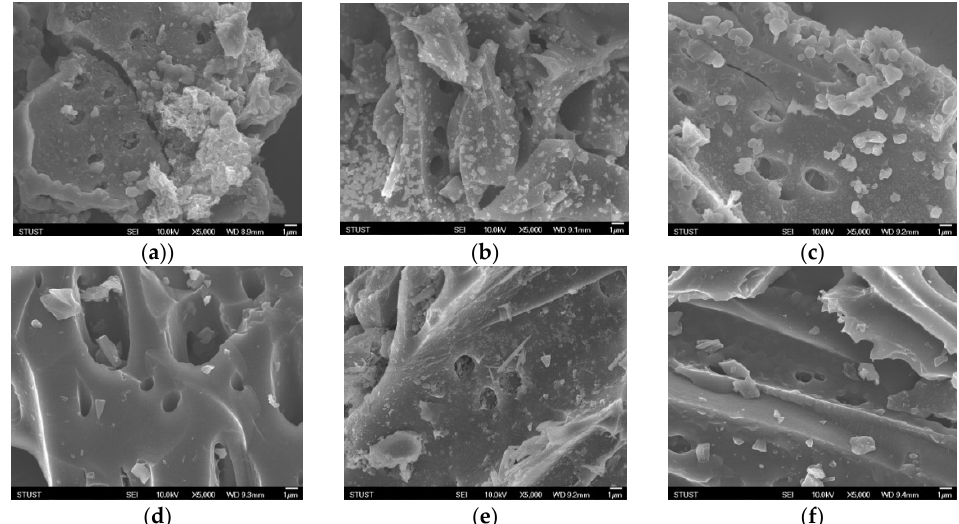
Figure 6. SEM micrographs (5000× magnification) of RFSFACs prepared with different impregnation ratios (1:3, 1:4, and 1:5). ( a – c ) with KOH; ( d – f ) with ZnCl 2 .